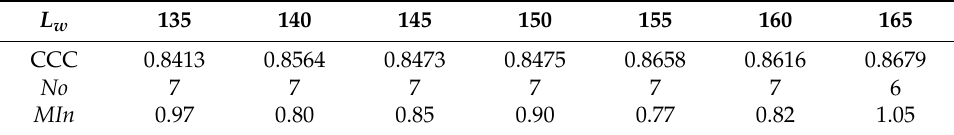
Table 2. Characteristic parameters for the selection of the optimal window (step 4): The window size L w , the optimal number of clusters No , the Cophenetic Correlation Coefficient CCC, and the minimum value of the S_Dbw index MIn .